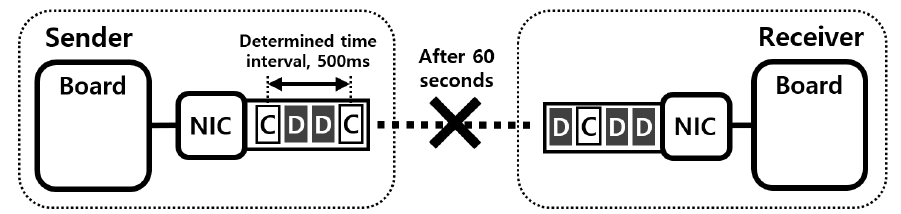
Figure 9. The experiment setup for evaluating the existing system in the problem